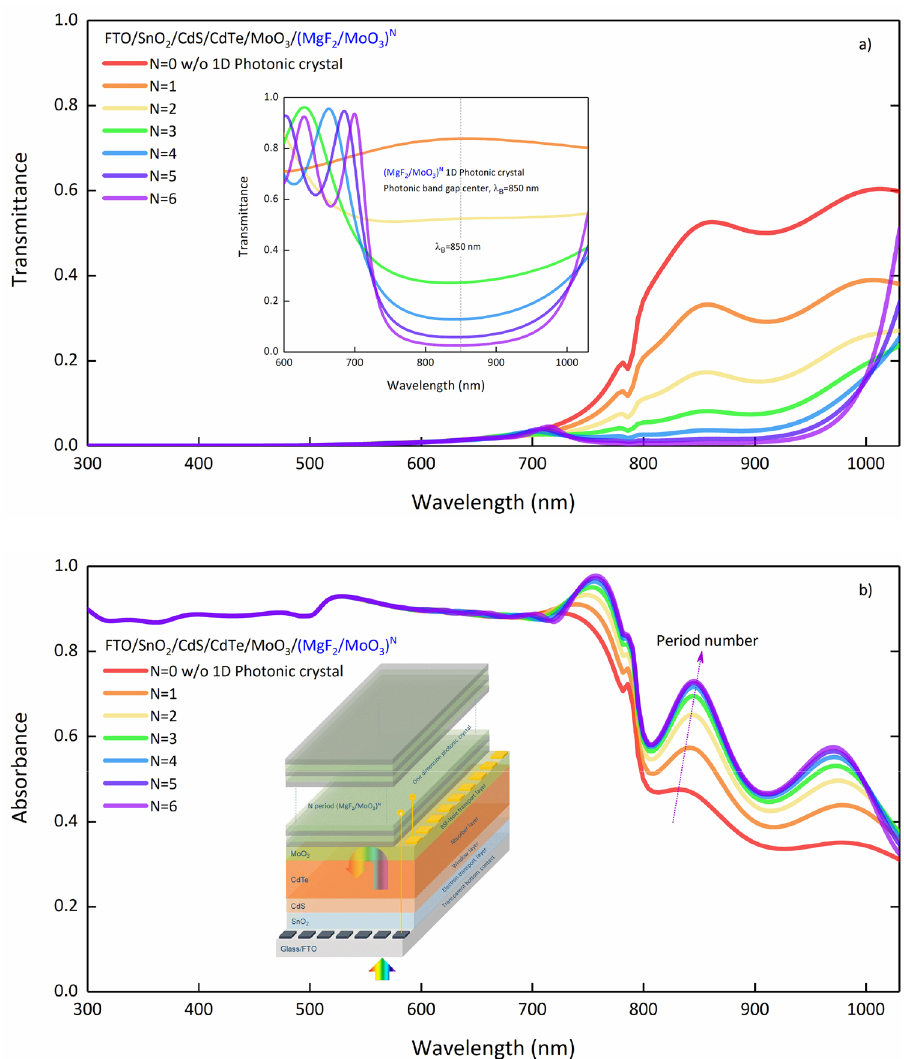
Figure 4. ( a ) Transmittance and ( b ) absorbance spectra of the FTO/SnO 2 /CdS/CdTe/MoO 3 /(MgF 2 /MoO 3 ) N SC calculated for different periods at (cid:31) B =850 nm. The transmittance spectrum of (MgF 2 /MoO 3 ) N 1D-PC as inset is given in ( a ). In ( b ), the SC containing 1D-PC is given as